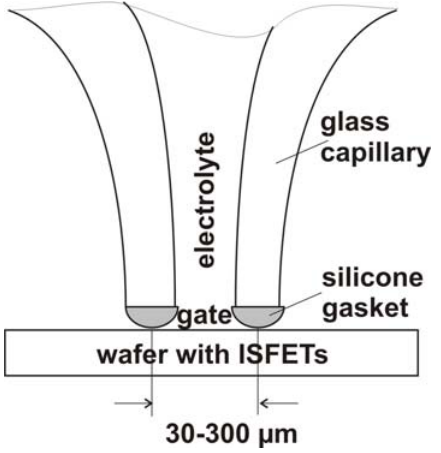
Figure 2. Capillary microcell for spatially resolved electrochemical measurements on wafer level. A silicone gasket at the tip of the capillary defines the testing